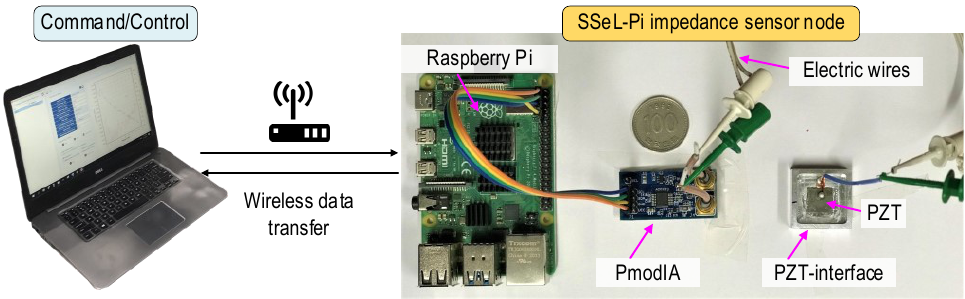
Figure 7. Prototype of impedance monitoring system ‘ SSeL-Pi ’ .